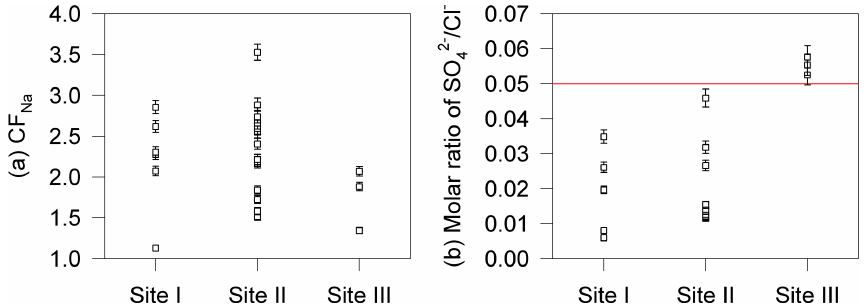
/ Na + in frost flowers at each sampling site. 4